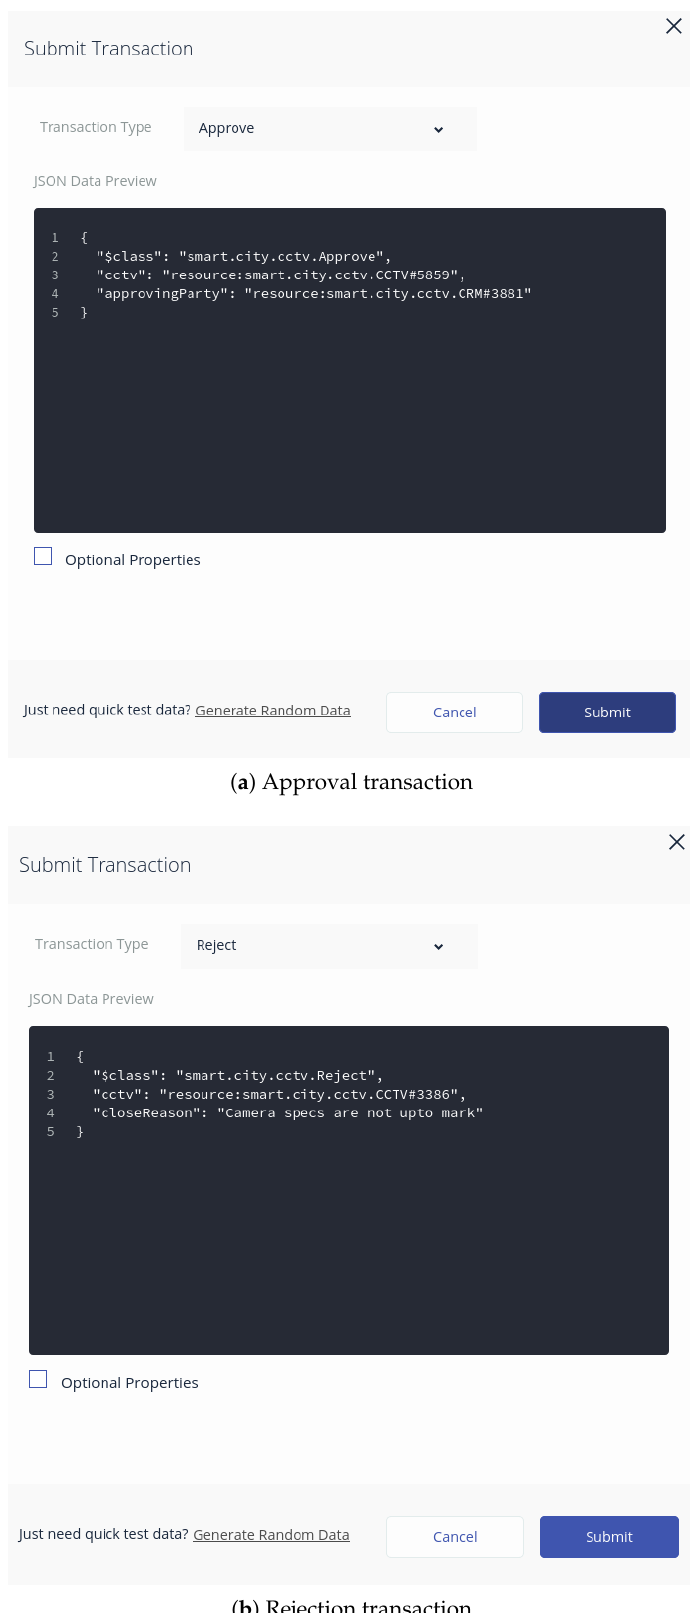
Figure 10. Submitting new